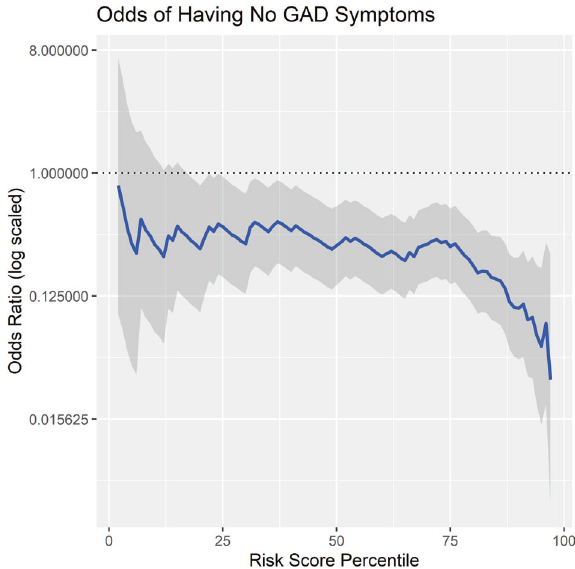
Fig. 4 This plot depicts the odds of reporting no GAD symptoms (de fi ned as declining all symptom criteria) at varying levels of risk scores. The gray lines depict the 95% con fi dence intervals of the odds ratios.